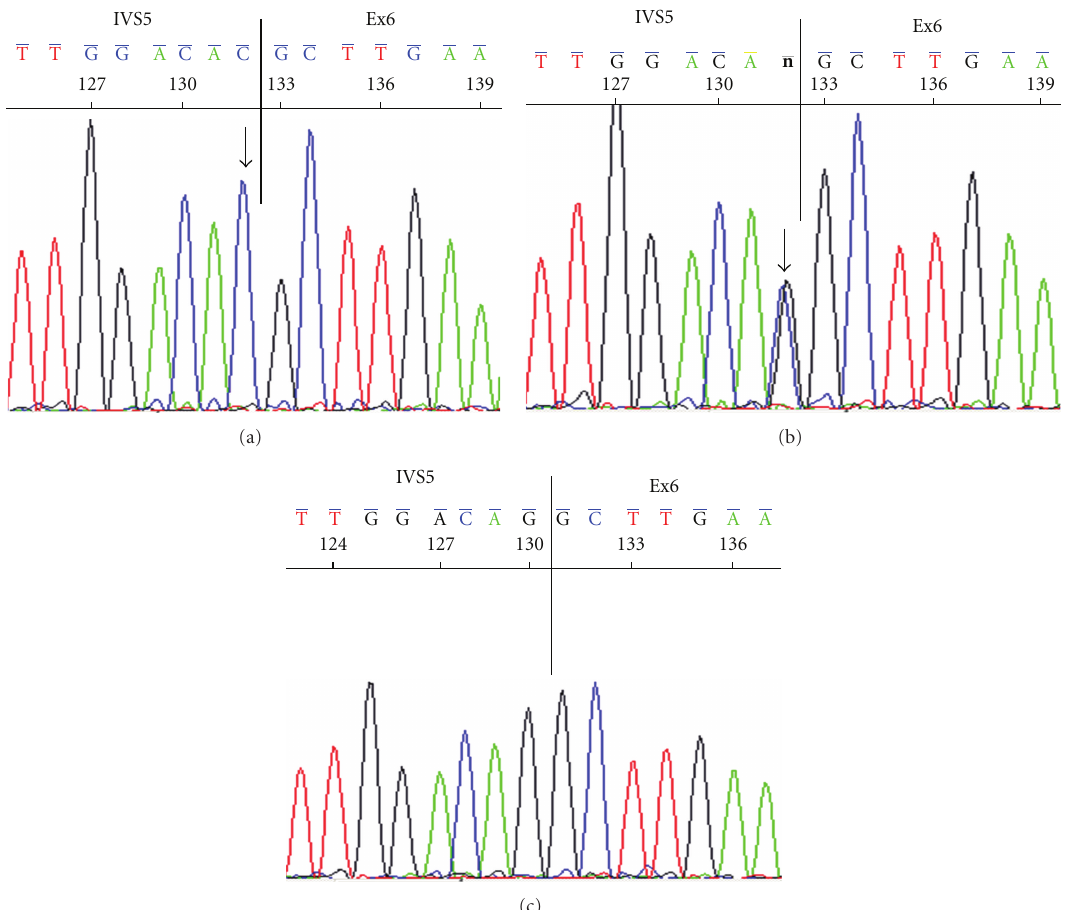
Figure 3: Sequencing of intron5 of SLC2A2 for family two showed: (a) For patient, there is G-to-C substitution at position-1 of the splicing acceptor site in a homozygous pattern (c.776-1G > C or IVS5-1G > A). (b) Individuals 2102, 2104, 2201, 2202 and 2204 were heterozygous for c.776-1G > C mutation. (c) Individuals 2101, 2103, and 2203 did not show this mutation.